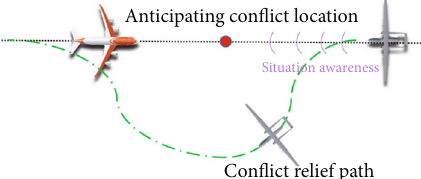
Figure 5: Situation awareness and con fl ict relief